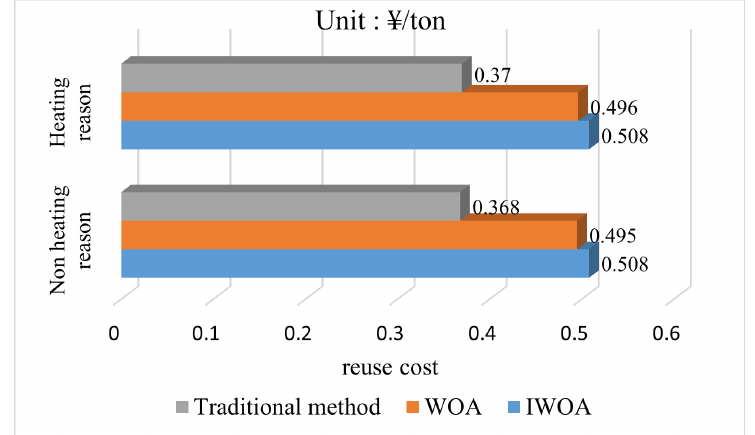
Figure 16. Comparison chart of reuse cost per ton of water.